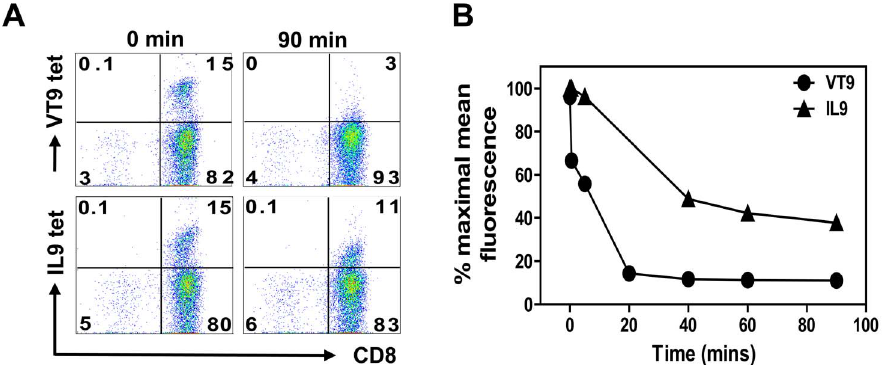
Figure 3. Differences in TCR/pMHCI dissociation. Panel A shows the reduction of VT9: and IL9:tetramer binding over 90 min in the presence of excess anti-HLA-A2-specific mAb BB7.2 to prevent reattachment of cognate peptide-specific CD8 + T cells. Panel B shows decreasing percent maximal mean fluorescent staining during this period.